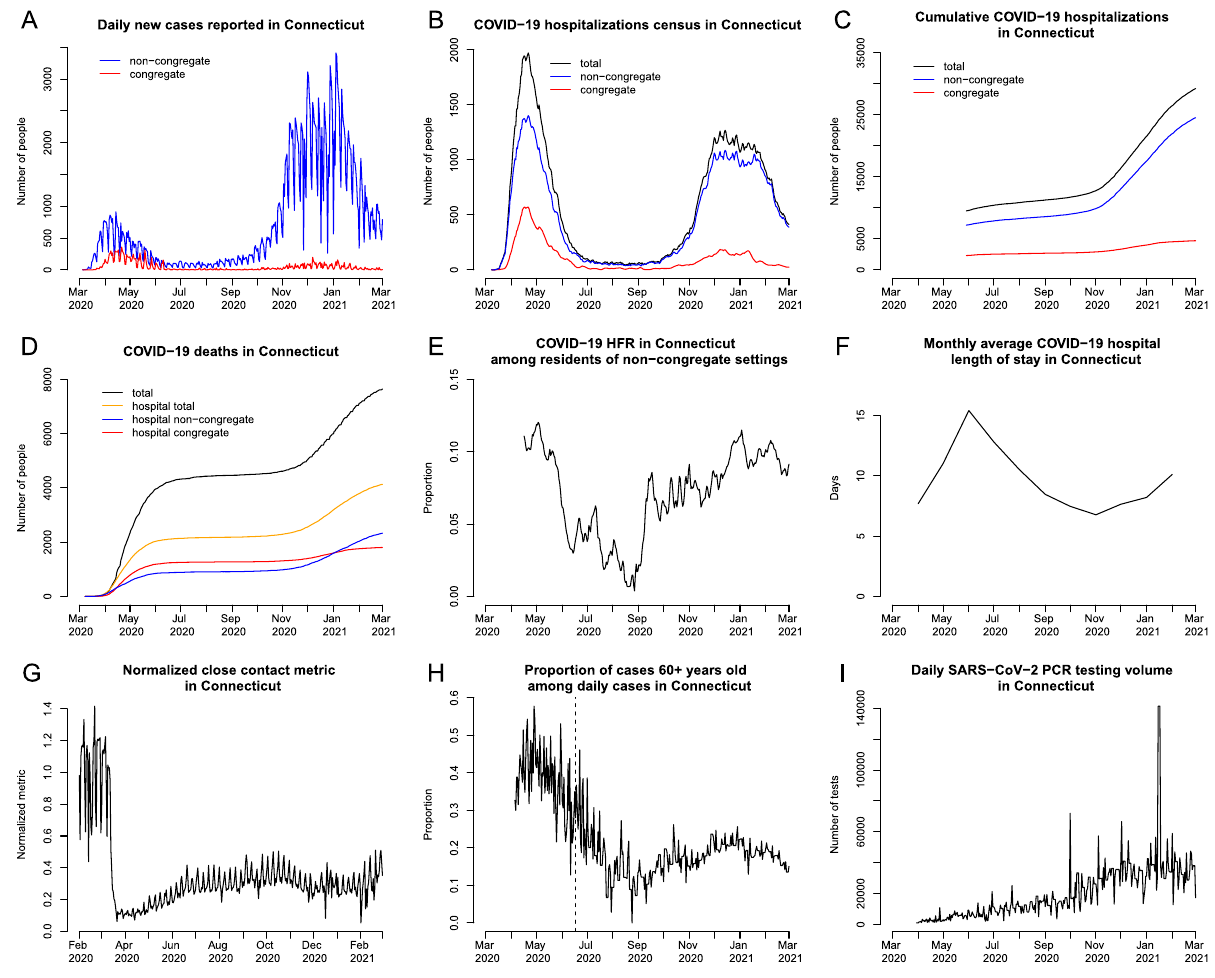
Figure 1. Observed and estimated data used in model calibration and approximation of time-varying model parameters. ( A ) daily new cases reported in Connecticut by the date of specimen collection among residents of non-congregate and congregate settings; ( B ) COVID-19 hospitalization census; ( C ) cumulative COVID-19 hospitalizations. In plots ( B ) and ( C ), the total number (black line) represents observed data, while non-congregate (blue) and congregate (red) lines represent estimates. ( D ) cumulative COVID-19 deaths in Connecticut; ( E ) hospital case fatality ratio (HFR) among hospitalized residents of non-congregate settings (estimated); ( F ) average length of hospital stay among COVID-19 patients by month; ( G ) normalized close interpersonal contact metric relative to the pre-epidemic period; ( H ) proportion of cases 60+ years old among daily COVID-19 cases (only data on the right of the dashed line is used in model parametrization); ( I ) daily PCR testing